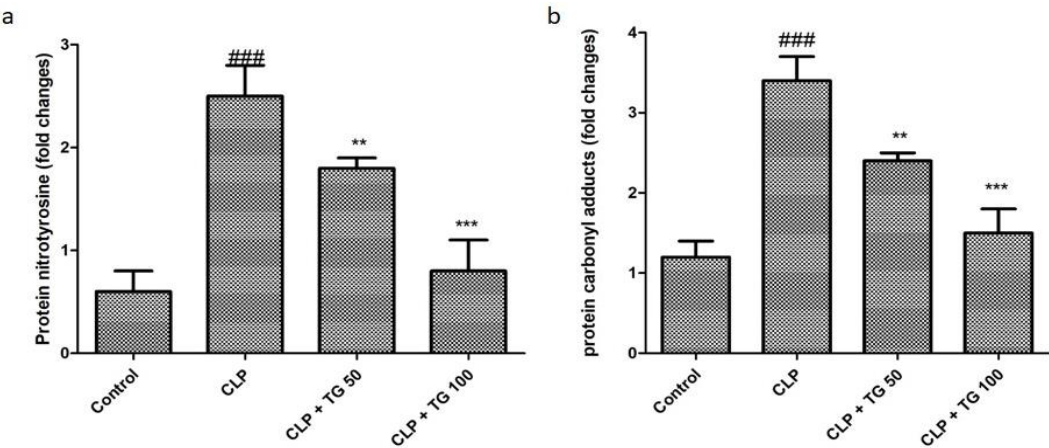
Figure 6. Cardiac oxidative markers: ( a ) protein nitration and ( b ) carbonyl content measured by quantitative ELISA (enzyme-linked immunosorbent assay). All markers were significantly increased in CLP-rats. TG (50 and 100 mg / kg) in significantly reduced CLP-induced oxidative stress markers, dose-dependently. Values represented as means ± SD and n = 12 / group. One-way analysis of variance (ANOVA), followed by Tukey’s test were used for statically analysis. Where ### p < 0.001 when compared to control group, whereas ** p < 0.01 and *** p < 0.001 when compared CLP group of animals. The level of antioxidant glutathione in oxidized and reduced form is also determined, and these levels of glutathione either oxidized form or reduced form are reversed by the treatment of TG 50 and 100 mg / kg in the dose-dependent manner (Figure